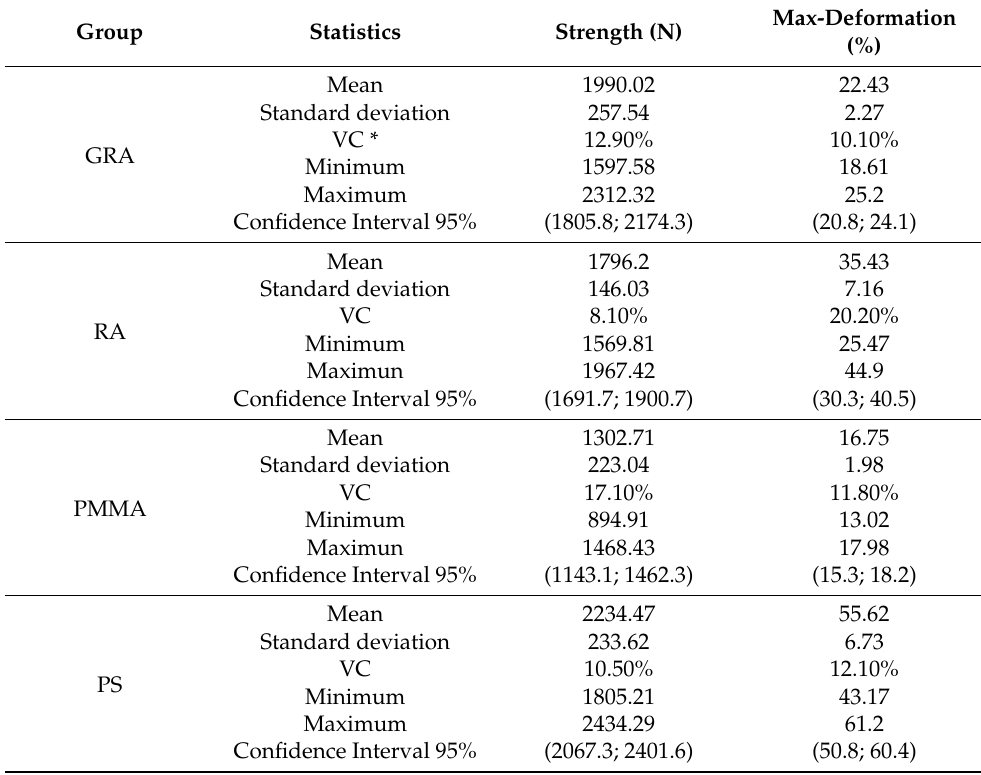
Table 2. Descriptive summary of the fracture resistance and deformation of the four materials studied.